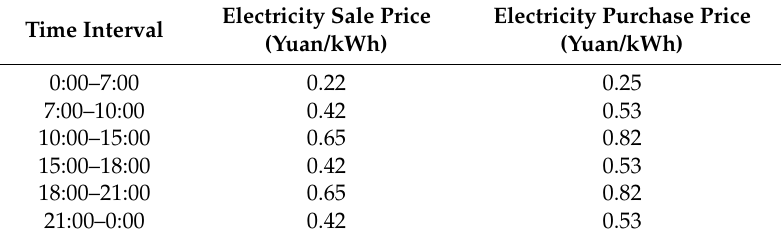
Table 2. The price of electricity sale and purchase.